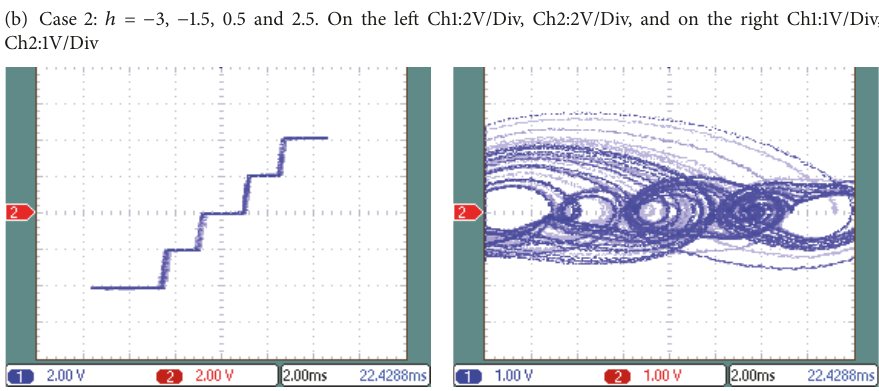
6.1. Synchronization of Nonoptimized 4-Scroll with Case 1 in Table 4: Different Slopes. By using different slopes for SNLF (irregular) as given in case 1, Table 4, the resulting 4-scroll chaotic attractor can be synchronized with another 4-scroll chaotic attractor that preserves traditional values for system’s parameters as well as a regular SNLF. For master system, we use the slopes = 10, 10, 5 (case 1, Table 4) for irregular SNLF, system’s parameters 𝑎 = 1.0 , 𝑏 = 0.709 , 𝑐 = 0.290 , 𝑑 1 = 1.0 , synchronization gains 𝑘 1 = 4, 𝑘 2 = 20, 𝑘 3 = 45 , and initial conditions 𝑥(0) = 1, 𝑦(0) = 1, 𝑧(0) = 0.01 . On the other hand, for slave system traditional values 𝑎 = 0.7 , 𝑏 = 0.7 , 𝑐 =